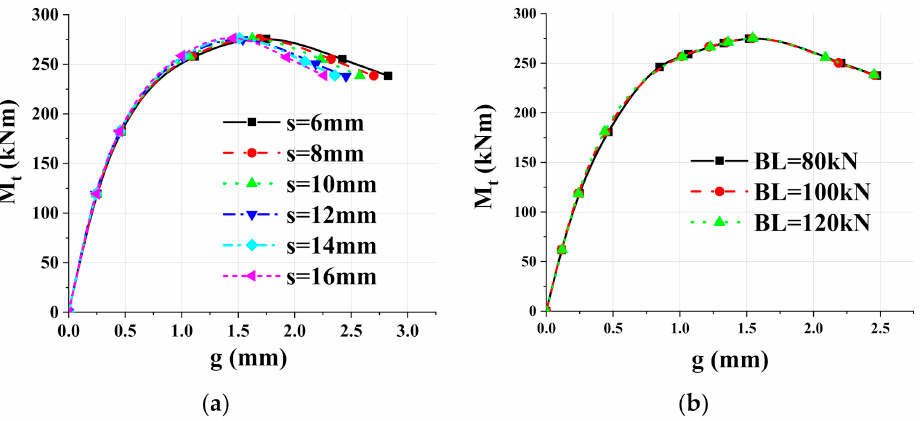
Figure 9. Moment-relative dislocation curves of connections: ( a ) Thickness of side plate; ( b ) Bolts preload. The influence rule of side plate thickness and bolts preload on continuity index were shown in Figure 10. As the thickness of side plate increases, the curve is closer to the horizontal axis, which means that the rotation difference between the upper and lower columns is smaller. For bolt preload influence, the connections with higher bolt preload have better continuity in the elastic stage, but there was no obvious difference in elastic– plastic